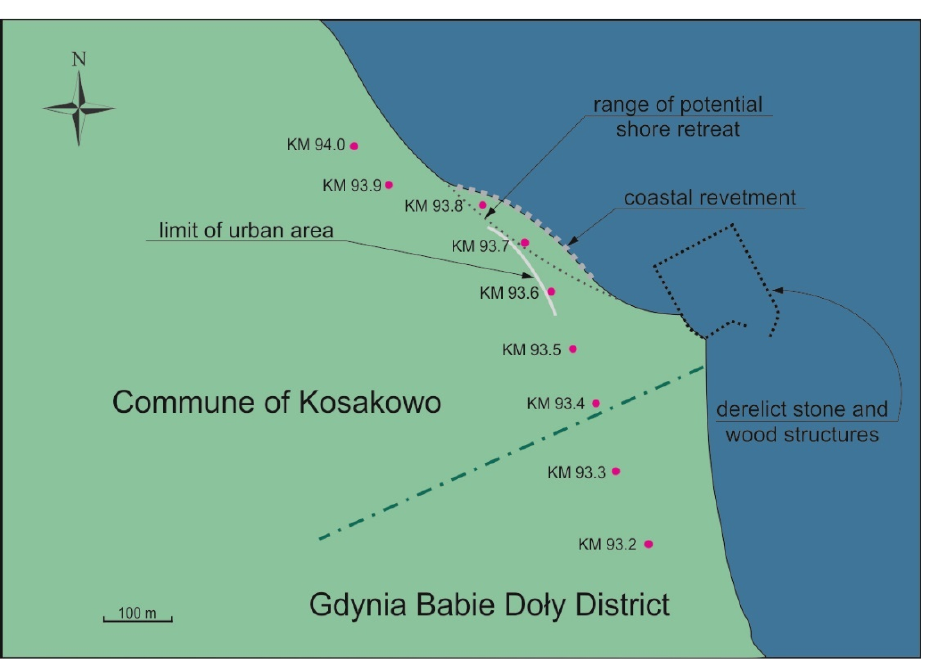
Figure 13. Range of potential coastal regression and of the existing building development in the section protected by the revetment (KM 93.6–93.9).